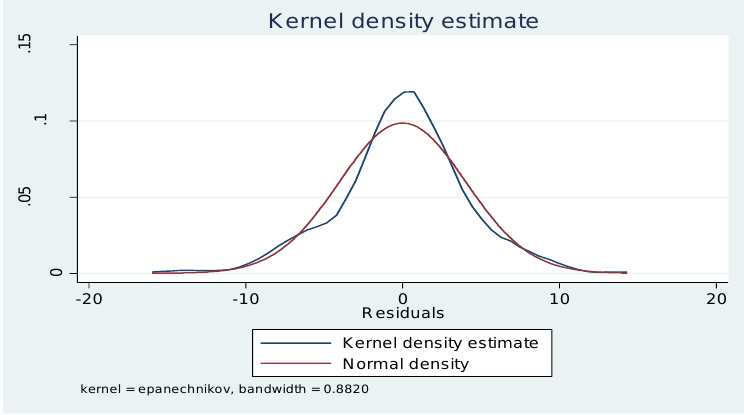
Figure 2: The Kernel Density Estimation (kdensity curve) for data normality; Source: Survey data,